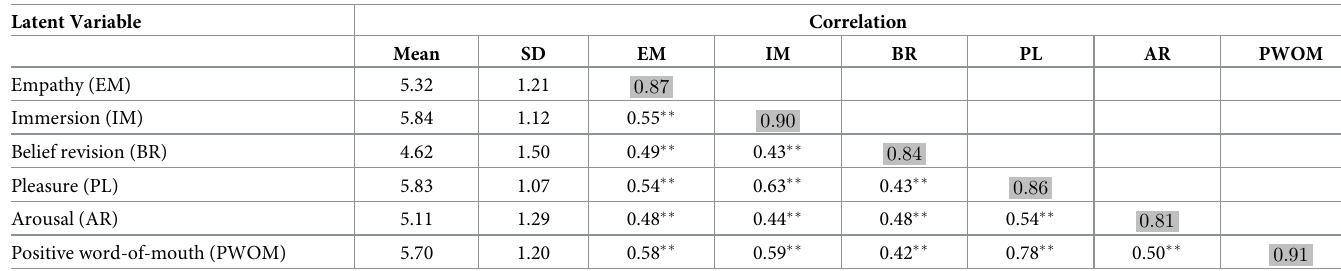
Table 2. Correlations among the latent variables.